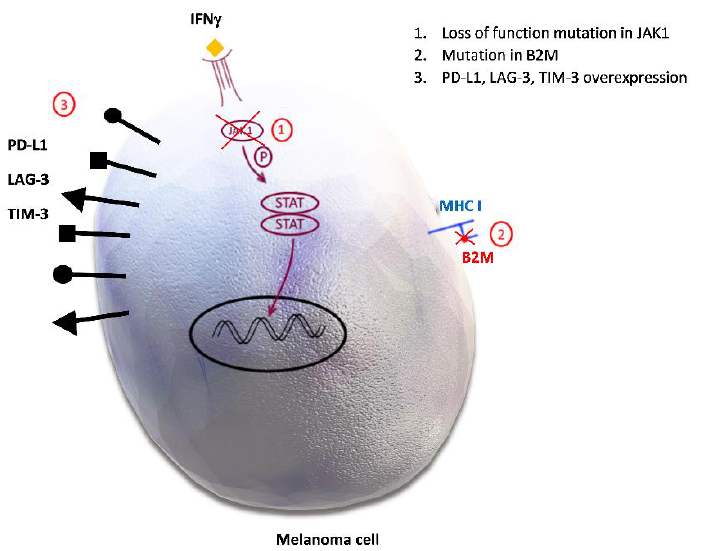
Figure 3. Potential mechanisms of acquired resistance to immune checkpoint inhibitors. 1. Loss of function mutation in Janus kinase 1/Signal transducer and activator of transcription (JAK1/STAT) inhibits downstream signal transduction and the interferon gamma (IFN- γ ) effect on melanoma cells. 2. Mutation in beta 2 microglobulin (B2M) causes defective B2M and major histocompatibility complex I (MHC I) molecule, therefore disabling the priming of cytotoxic CD8+ cells. 3. Programmed death-ligand 1 (PD-L1), lymphocyte activation gene-3 (LAG-3), T-cell immunoglobulin and mucin domain 3 (TIM-3) overexpression promotes inhibitory signals in effector T cells, leading to their anergy. Janus Kinase 1 and 2/Signal transducer and activator of transcription) (JAK 1,